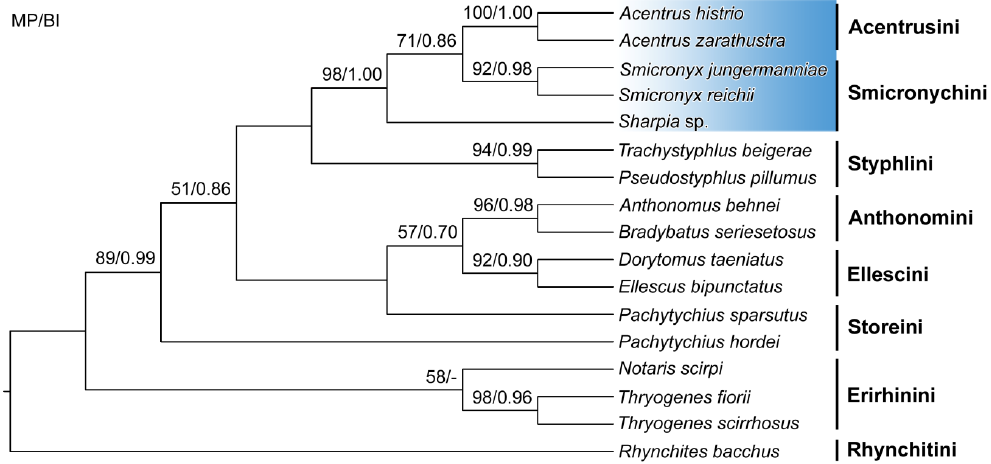
Figure 4. Weighted most parsimonious tree inferred from 38 characters of 16 species belonging to seven tribes of the family Curculionidae and one outgroup species ( Rhynchites bacchus ). The tree was constructed with the maximum parsimony method using PAUP*. Nodal supports are indicated as maximum parsimony (MP) bootstrap values in % and posterior probabilities for the Bayesian inference (BI). A dash indicates support below 0.50. Nodes without statistical support were not recognized in Bayesian and MP bootstrap analyses.